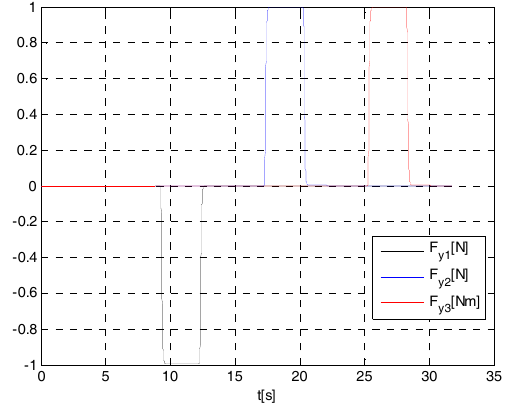
Figure 31. Behaviors of the forces F yi .